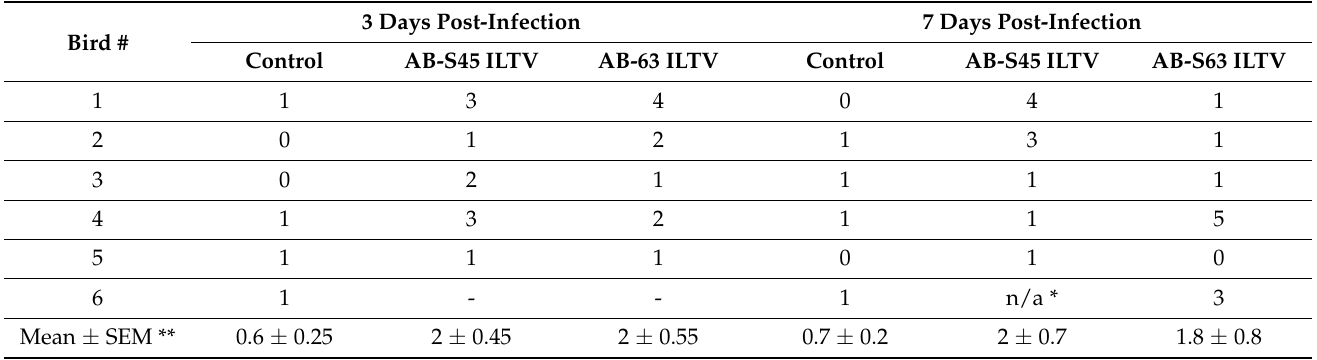
Table 1. The lesion scoring of histopathological lesions in the tracheas of chickens at 3 and 7 days after exposure to wildtype (AB-S63) and CEO vaccine revertant (AB-S45) ILTV isolates.